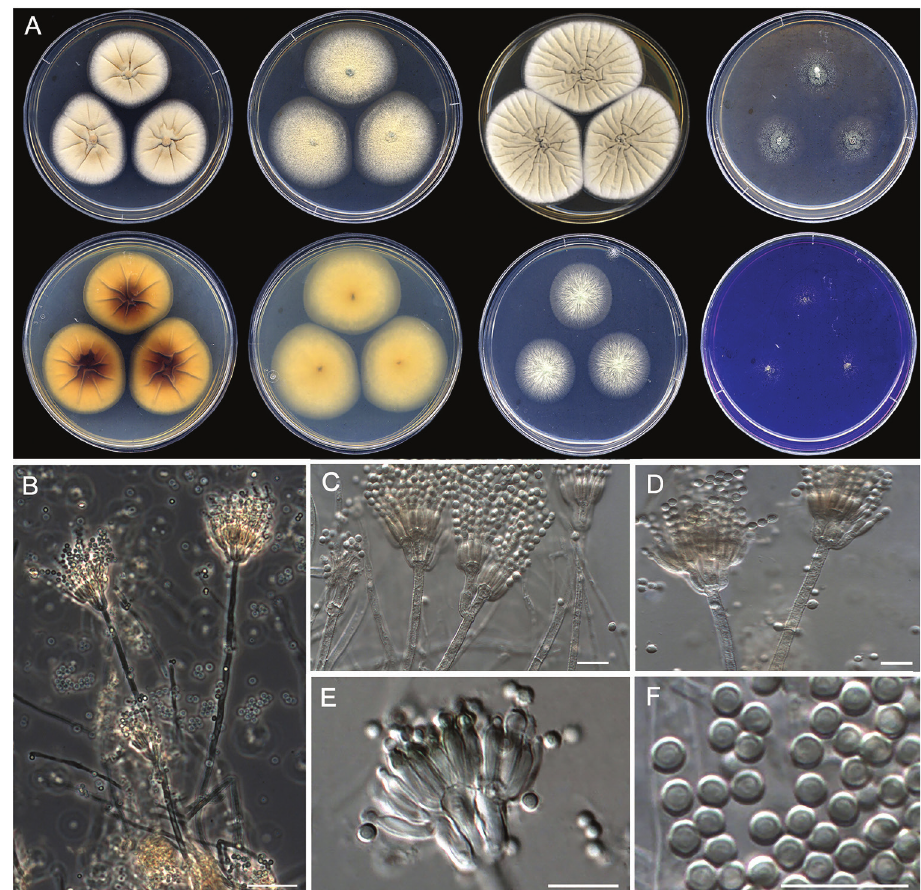
Figure 10. Morphological characters of Penicillium guarroi sp. nov. (ex-type FMR 17747). A colonies from left to right (top row) CYA, MEA, YES, and OA; (bottom row) CYA reverse, MEA reverse, DG18, and CREA B–E conidiophores on MEA F conidia. Scale Bars: 25 μm ( B ), 10 μm ( C–F